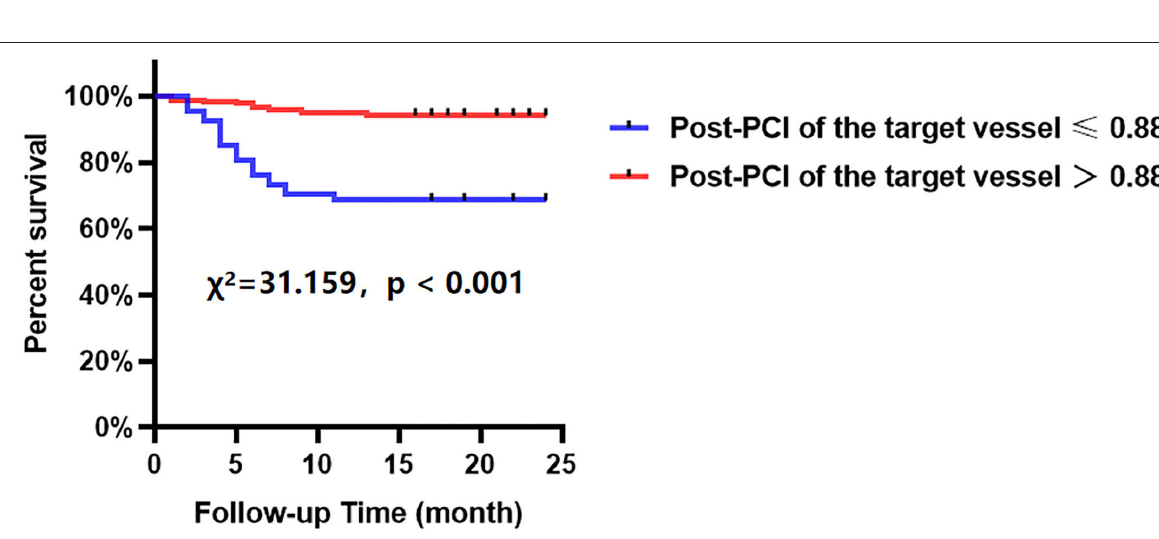
Frontiers in Cardiovascular Medicine |